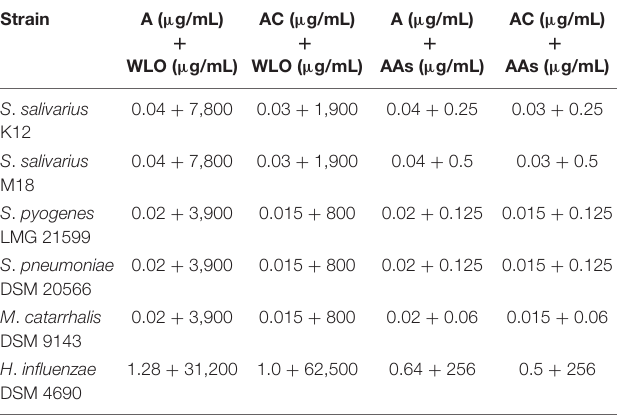
coincides with the MBC. This does not apply to H. influenzae